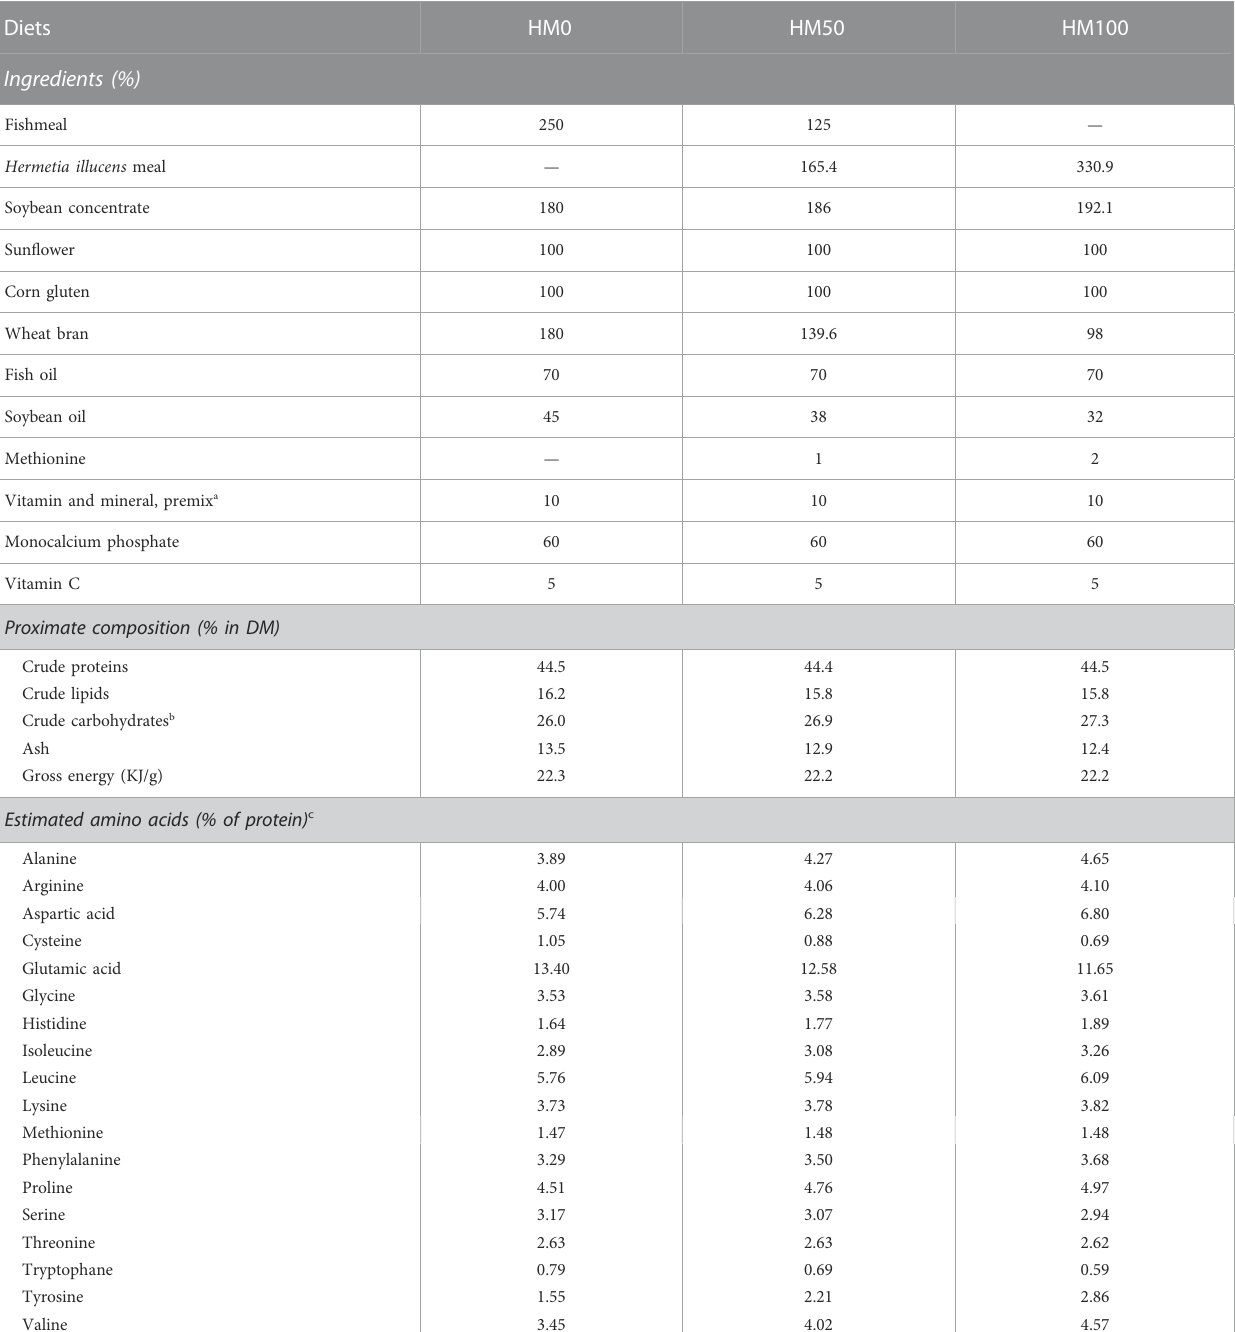
TABLE 2 Formulation (g/kg of diet), proximate composition (% in dry matter) and estimated amino acid content (% of protein) of the experimental diets. Diets HM0 HM50 HM100